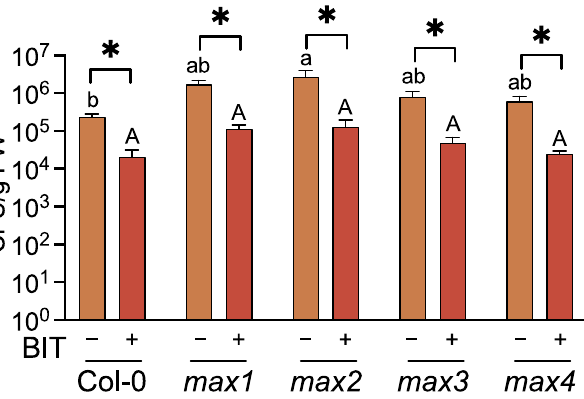
Figure 1. Effects of BIT treatment on growth of Pseudomonas syringae pv. tomato DC3000 in Arabidopsis leaf tissues. Three-week-old plants were treated with water (control) (–) or BIT (1 mg/pot) (+) using the soil drenching method 3 d before inoculation with Pst (2 × 10 5 CFU/mL). Leaves were homogenized at 3 d post-inoculation, and the number of CFU was estimated using their growth on nutrient broth agar plates. Values are means ± SE from six replicates, each with three leaves. Significant differences between the control and BIT-treated leaves are indicated by * (unpaired t -test, p < 0.05). Different letters indicate significant differences between accessions of the same treatment (Tukey’s multiple comparison test, p <